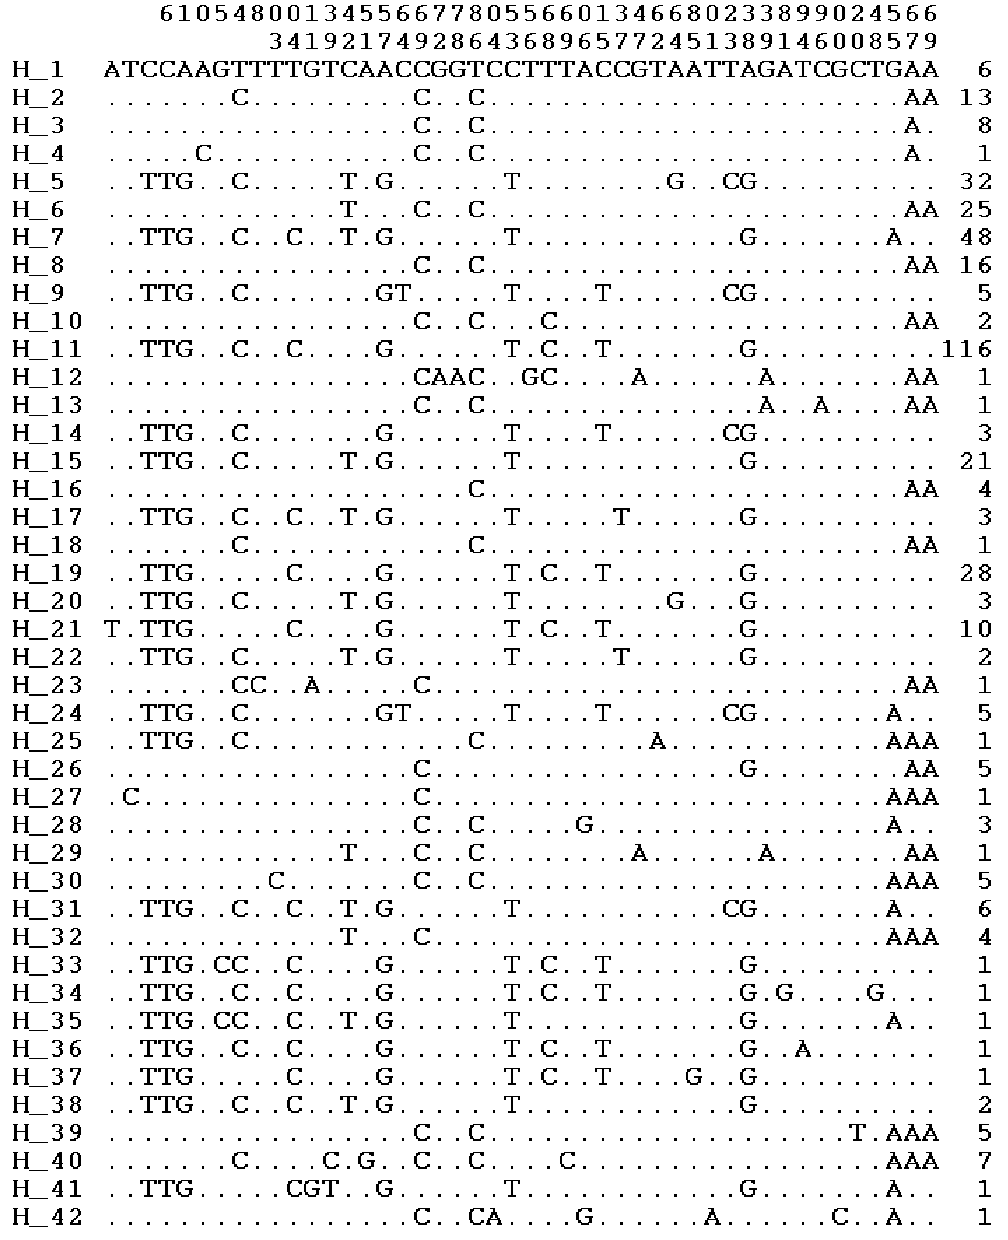
Figure 1. Polymorphic sites and haplotypes.